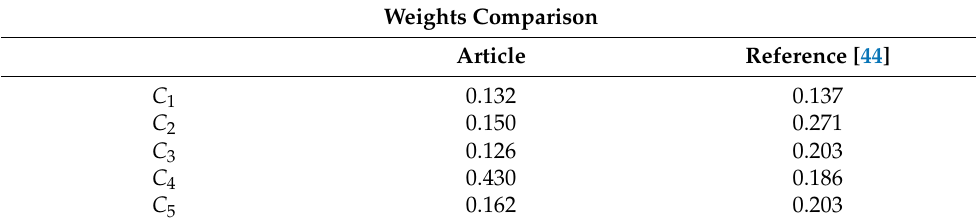
Table 5. Weight comparison of different decision-making methods.